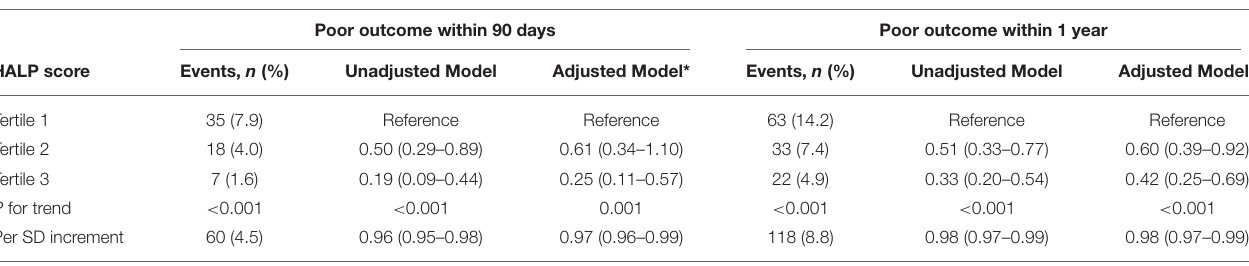
TABLE 2 | HRs (95% CIs) for poor outcome according to HALP score